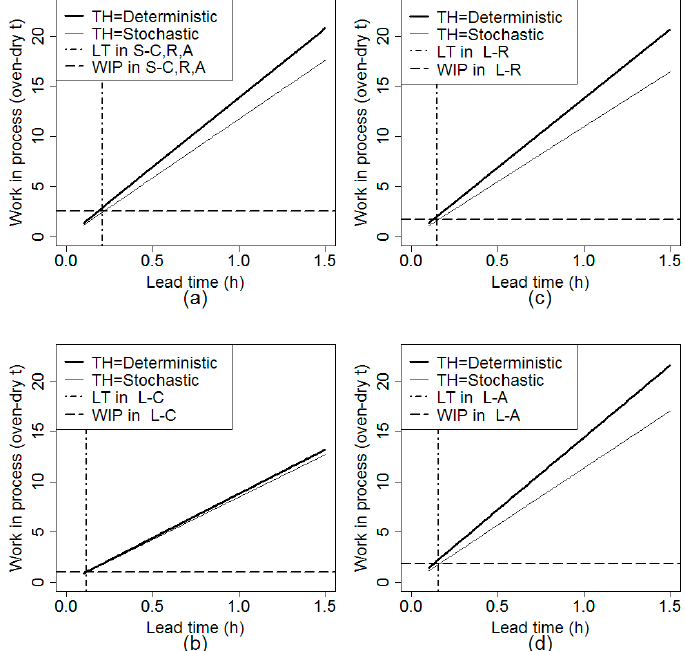
Figure 2. Relationship among the throughput, the work in process and the lead time; ( a ) in the cases S-C, S-R, S-A; ( b ) in the case L-C; ( c ) in the case L-R; and ( d ) in the case